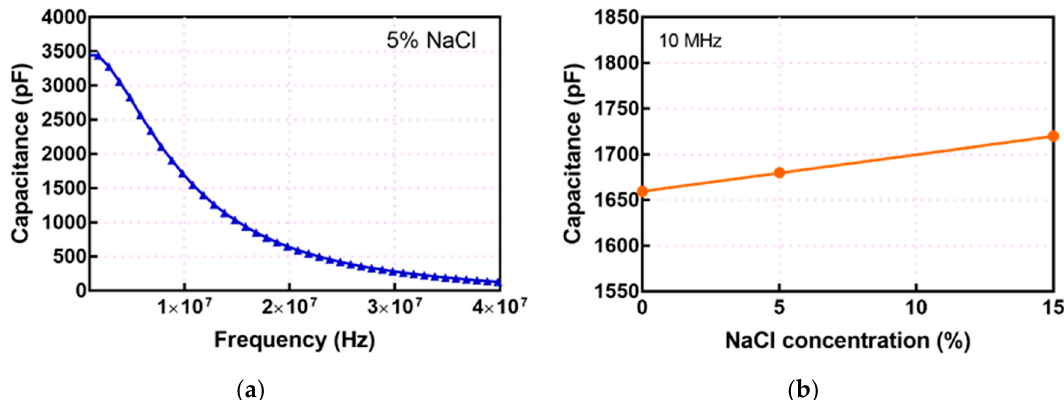
Figure 12. Capacitance of microfluidic capacitor as a function of: ( a ) frequency for 5% NaCl solution, ( b ) different concentration of NaCl solution inside the channel.